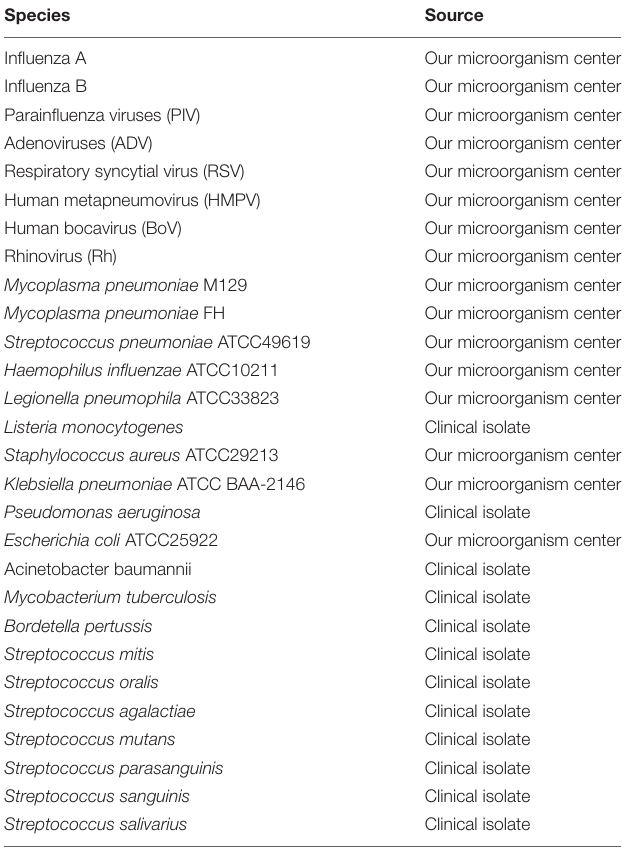
TABLE 1 | Viral and bacterial types used in this